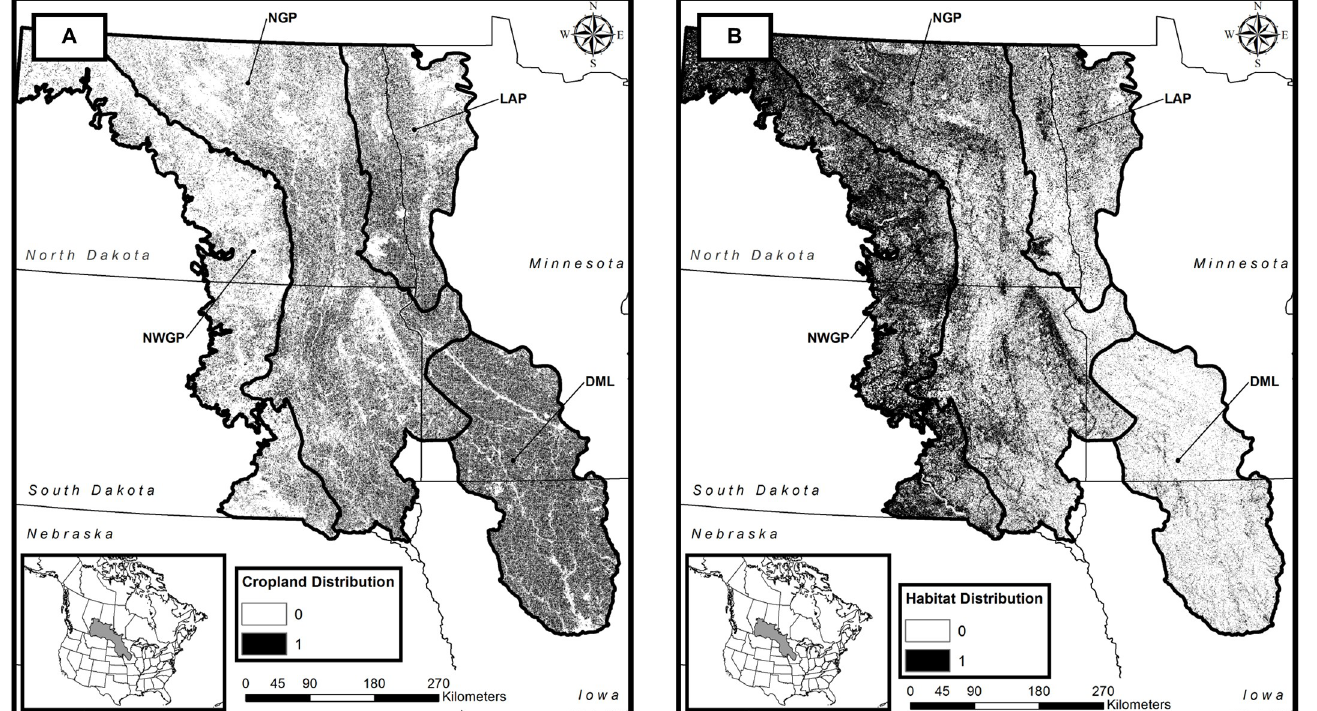
Fig 1. Distribution of cropland (Map A) and suitable grassland-bird habitat with an InVEST habitat-quality ranking � 0.3 (indicated in black) (Map B) in the Prairie Pothole Region of the United States in 2014. Ecoregions are the Northern Glaciated Plains (NGP), Northwestern Glaciated Plains (NWGP), Lake Agassiz Plain (LAP), and Des Moines Lobe (DML) ecoregions [28].